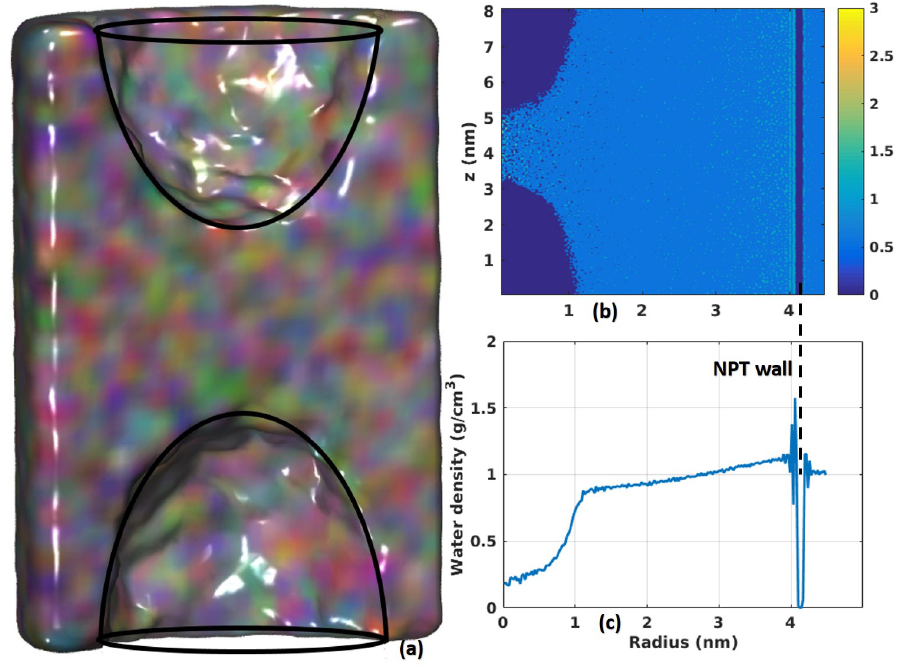
Figure 7. Taylor instability and vortex when ω = 90 rad/ns. ( a ) Two vortexes (sketched by black lines) are observed inside the container. The fluid is rendered as colored colloid for better 3D view. ( b ) Water density profile in radial-longitudinal plane. ( c ) Distribution of water density along radial direction. The Nano-Porous Tube (NPT) wall in the figure signifies the location of the CNT membrane wall and that its properties are held at constant over